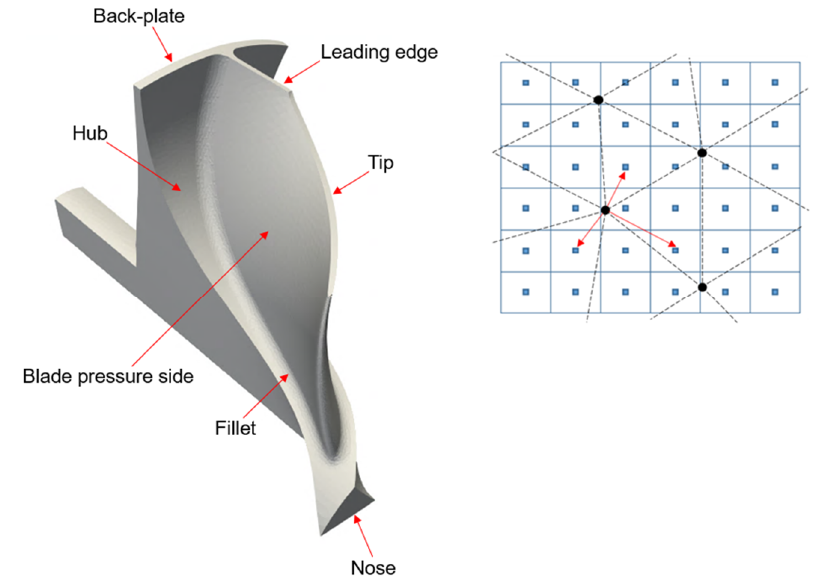
Figure 2. Radial turbine rotor surface split in sub-regions ( left ), example of FVM-FEM meshes correspondence identification ( right ).